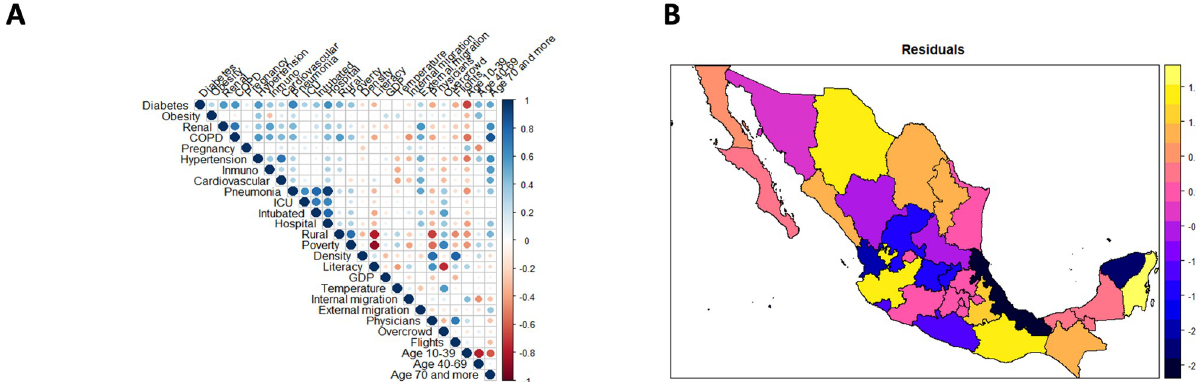
Fig 3. Figures associated with the selection and goodness-of-fit of a multivariable generalized geographically weighted model (GGWR), with a poison distribution, offset, and a logarithm link function explaining the mortality risk from COVID-19 among tested individuals. A) Correlation plot including the raw risks and B) Representation of Pearson residuals by state. Shapefile from http://tapiquen-sig.jimdo.com under a CC BY license, with permission from Carlos Efraı´n Porto Tapique´n, original copyright 2015. Notes: (1) Offset: Log of the total number of people tested in a state; (2) Multiplicative changes in mortality risks (MRt) from the effects of different risk factors by